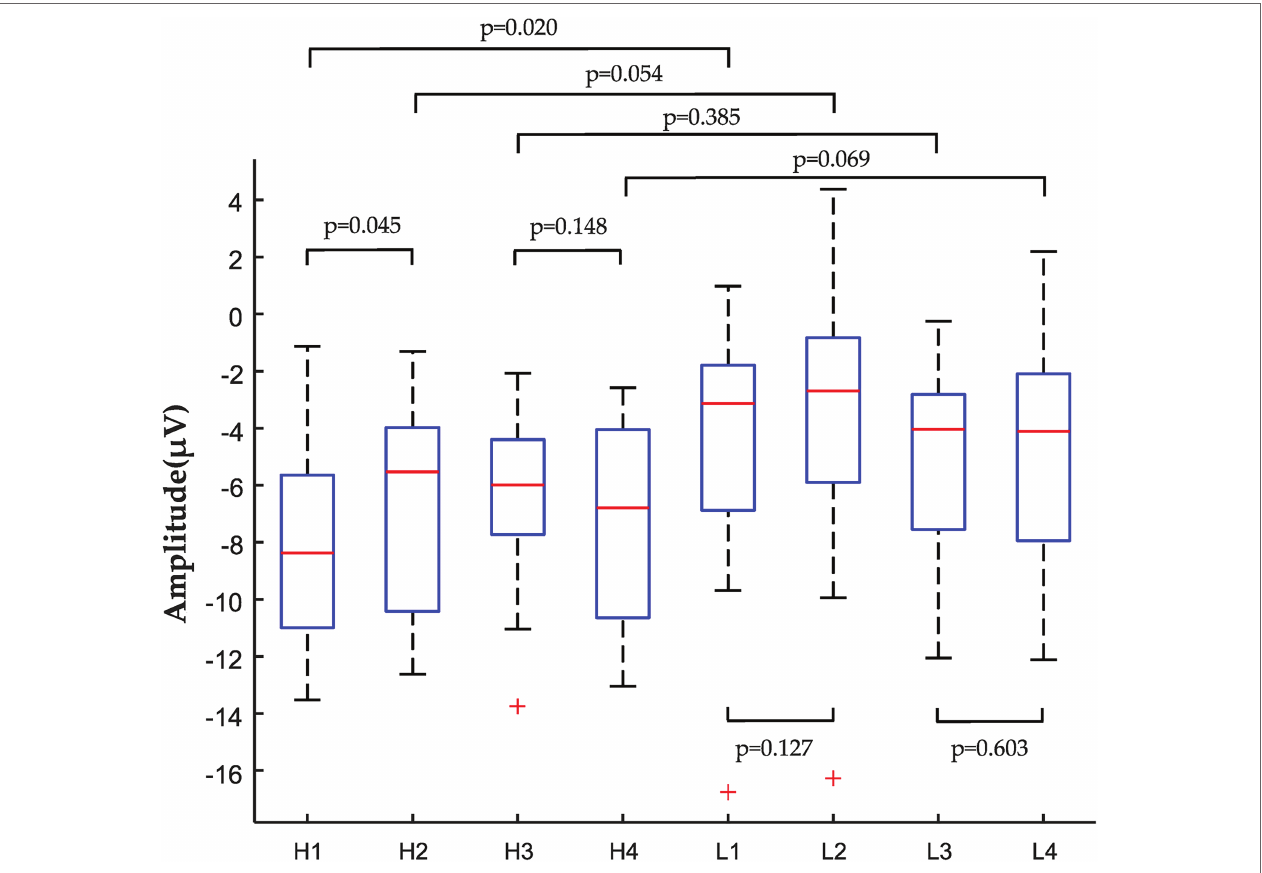
FIGURE 6 | ANOVA of peak amplitude data: the comparison of the housing tenure choice with adjectives and group of high and low Confucian culture influence. (H1: Renting-Positive; H2: Owning-Negative; H3: Renting-Negative; H4: Owning-Positive; L1: Renting-Positive; L2: Owning-Negative; L3: Renting-Negative; and L4: Owning-Positive).